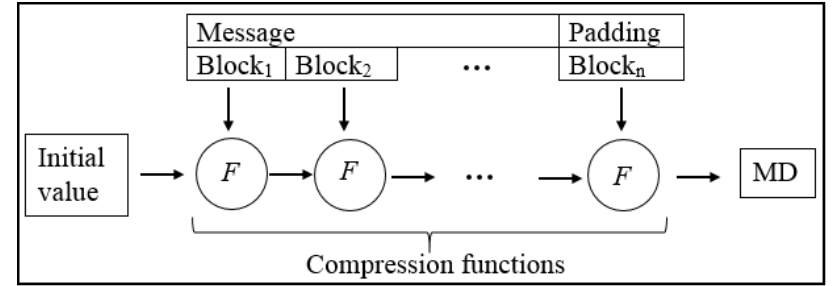
Figure 2. The Merkle–Damgard construction of SHA (0, 1 and 2) hash functions.